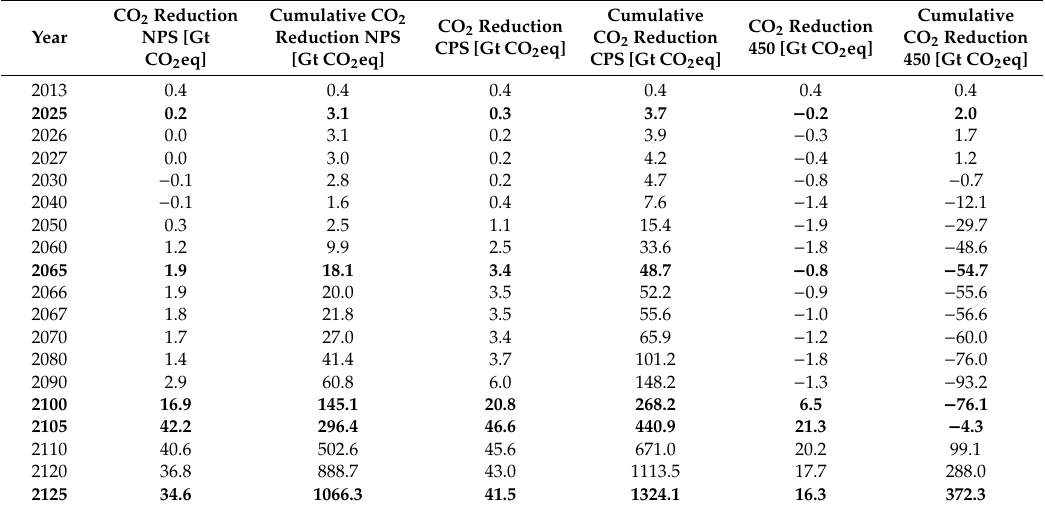
Table 9. Possible CO 2 emission reduction for scenario S2, sub scenario